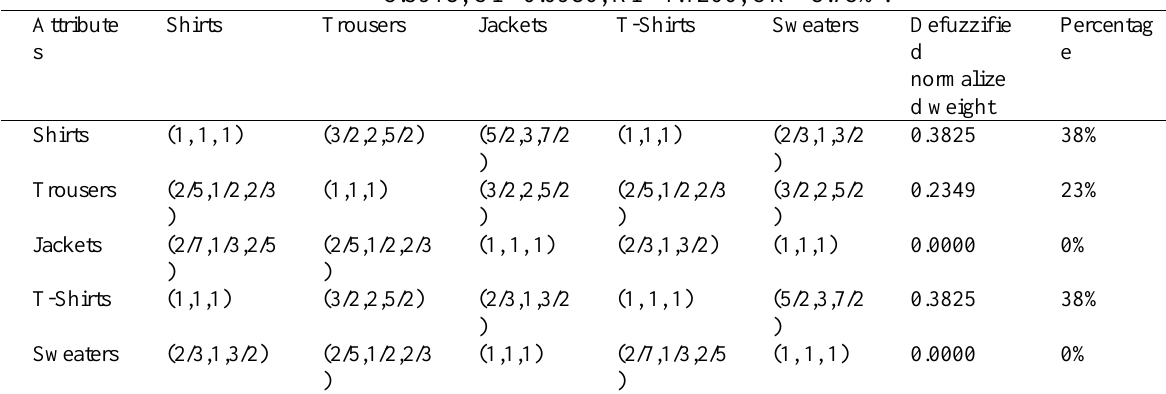
Table 8. The fuzzy comparison matrix for the “raw material availability”